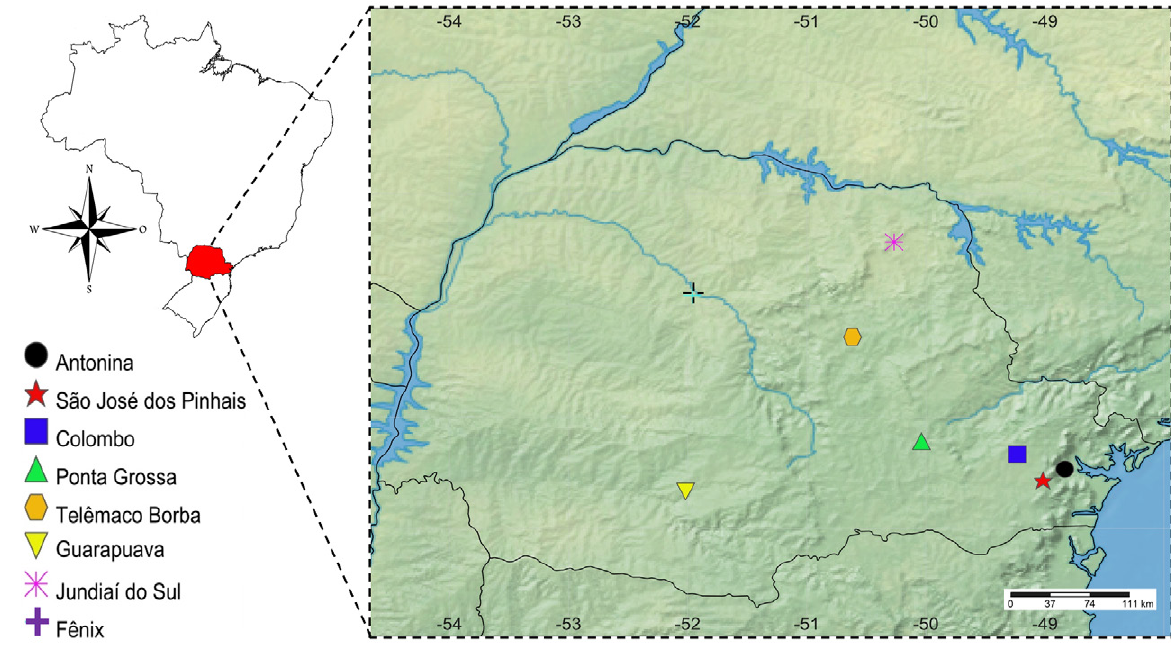
Figure 1. Map of Brazil (left) and Paraná state (right) with the sampled locates of the PROFAUPAR. Antonina (25°28 ′ 00 ʺ S, 048°50 ′ 00 ʺ W); São José dos Pinhais (25°34 ′ 00 ʺ S, 049°01 ′ 00 ʺ W); Colombo (25°20 ′ 00 ʺ S, 049°14 ′ 00 ʺ W); Ponta Grossa (25°13 ′ 02 ʺ S, 050°02 ′ 14 ʺ W); Telêmaco Borba (24°17 ′ 00 ʺ S, 050°37 ′ 00 ʺ W); Guarapuava (25°40 ′ 00 ʺ S, 052°01 ′ 00 ʺ W); Jundiaí do Sul (23°26 ′ 00 ʺ S, 050°16 ′ 00 ʺ W); Fênix (23°54 ′ 51 ʺ S, 051°57 ′ 45 ʺ